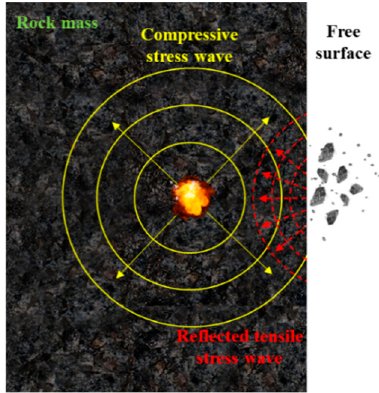
Figure 3. Effect of free surface in the rock blasting process.